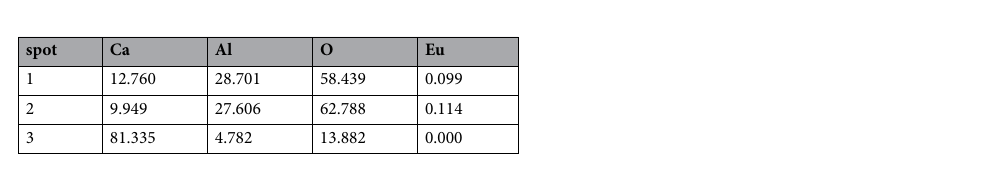
Table 1. Chemical constitution (at. %) of the particles in Fig. 3(a) by EDS